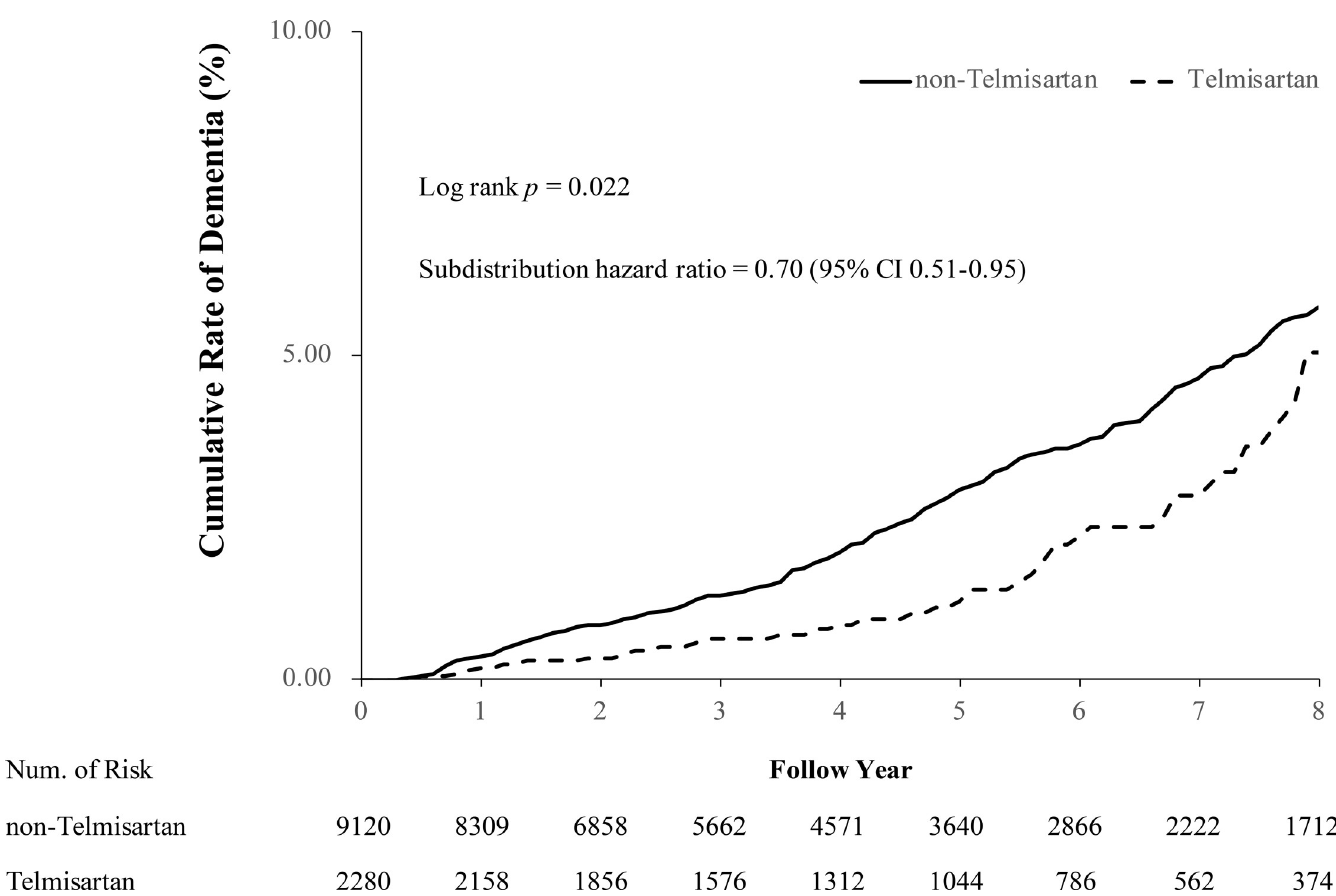
Fig 2. Comparison of the cumulative incidence of dementia between telmisartan and non-telmisartan angiotensin receptor blocker groups in the propensity- score-matched cohort. The curves show a lower risk of dementia diagnosis in the telmisartan group. The subdistribution hazard ratio considered ischemic stroke as a competing risk. The plot was truncated at the 8th year. CI, confidence